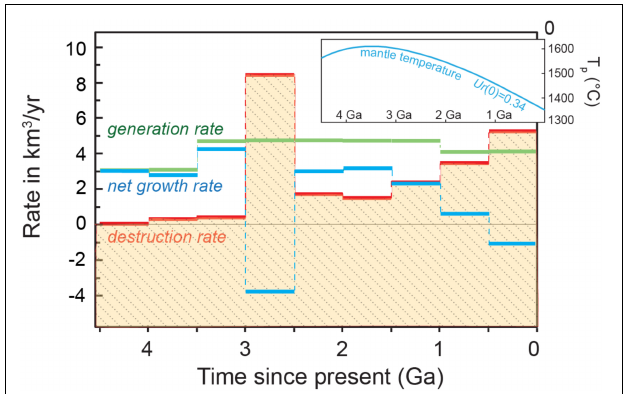
FIGURE 11 | A model for the changes in the volume and rates of generation and destruction of the continental crust through time (Dhuime et al., 2018). The model assumes that 60 to 80% of the present day volume of continental crust was established by 3 Ga, and seeks to reproduce the cumulative curve for the present day distribution of juvenile crust (Condie and Aster, 2010; Figure 10 ). The estimated rates of generation (green curve), destruction (red curve + shading) and net growth (blue curve) of the continental crust, are plotted in 500 Myr intervals. The inset shows the smooth evolution of the mantle temperature through time, after Herzberg et al. (2010), Korenaga